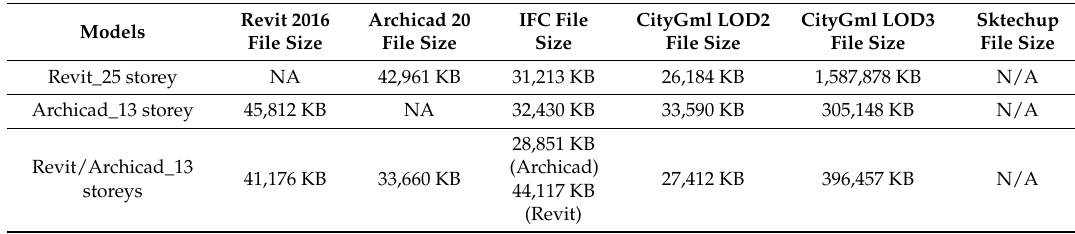
Table 3. Comparison between file type and file